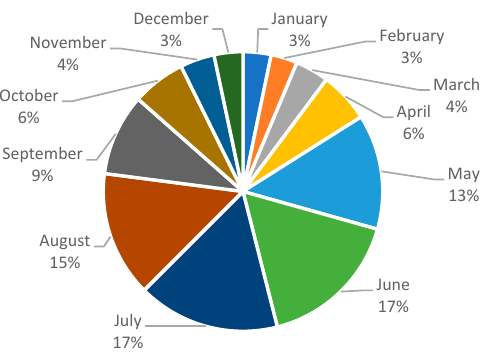
Figure 1. Monthly thermal cooling energy demand percentage of the commercial center (%) [51].